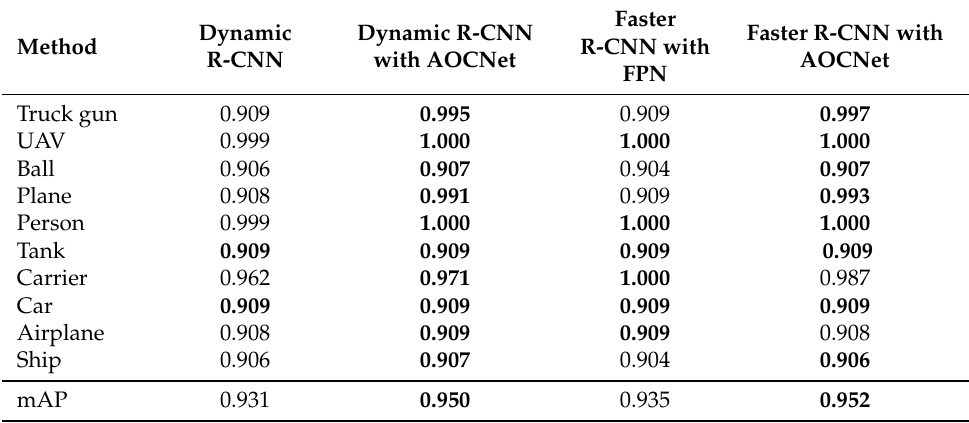
Table 5. The comparative experiments of different methods on our dataset.